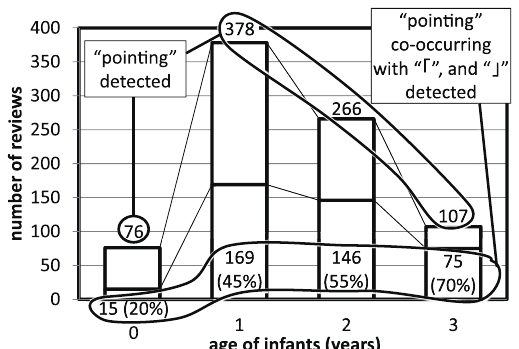
Fig. 1. Ratio of Pointing Behaviors with Vocalizations by Each Age (a): Picture Book Reviews (studied in this paper)